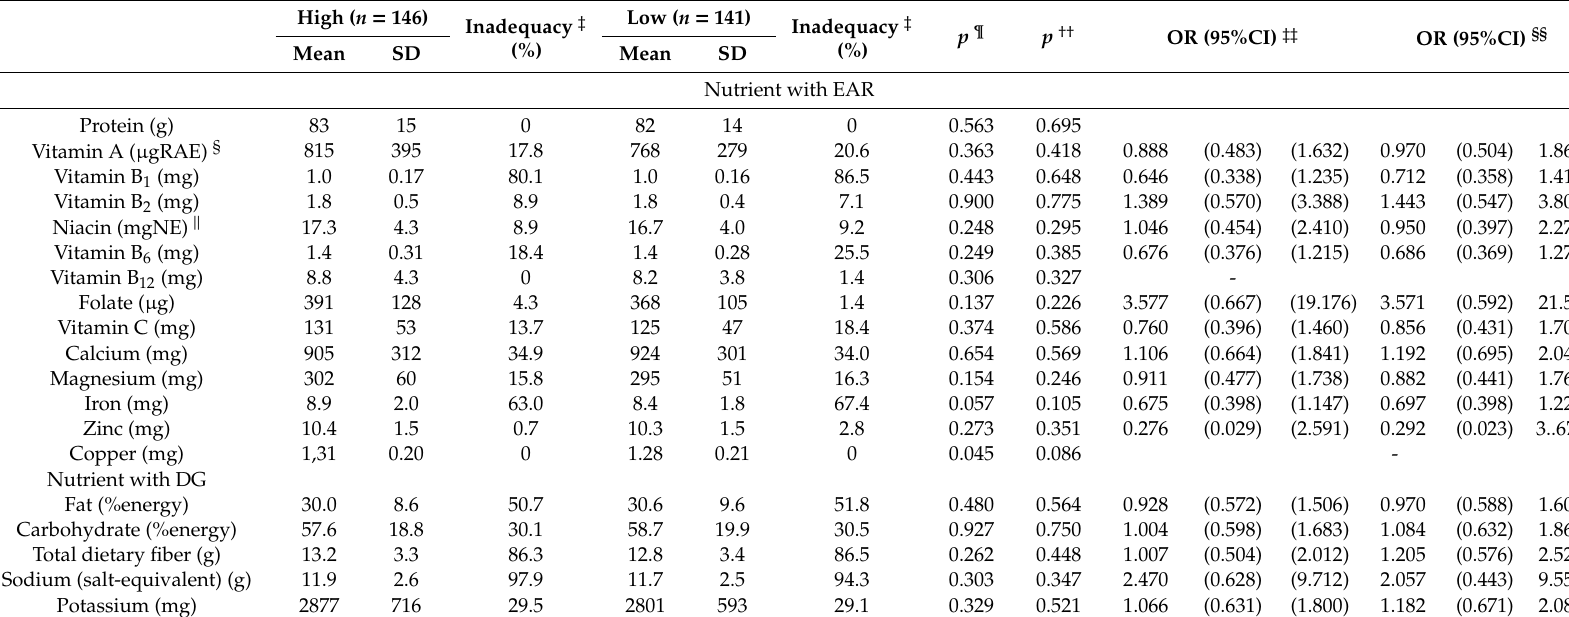
Table 2. Habitual daily nutrient intakes and prevalence of not meeting estimated average requirement (EAR) or preventing lifestyle-related disease(DG) of Dietary Reference Intakes(DRIs) among 287 junior high school students categorized into high and low groups by mothers’ nutrition knowledge level †